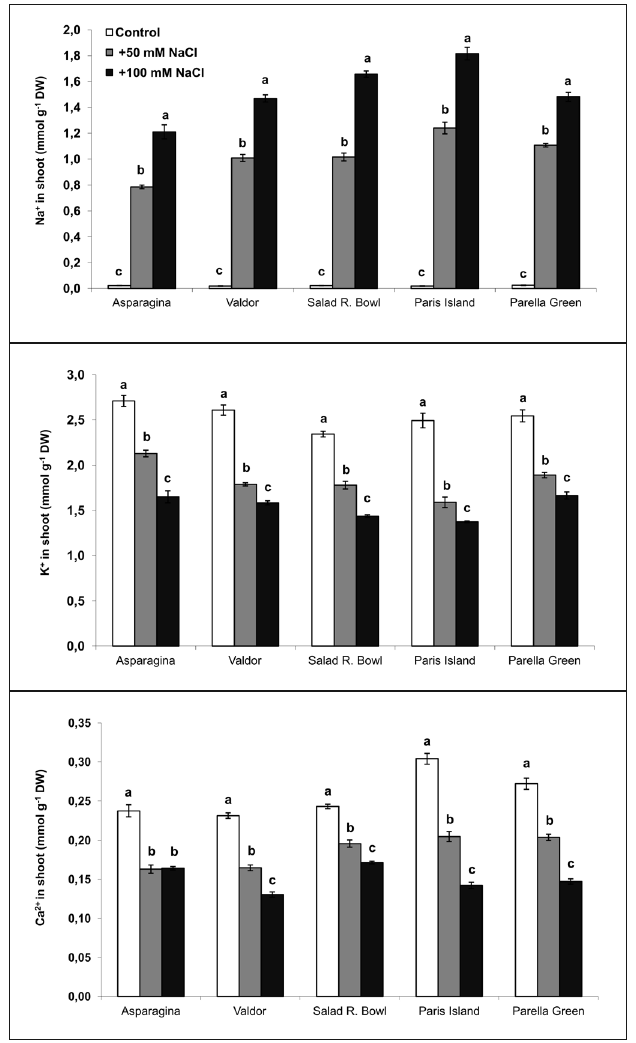
Fig. 5: Na + , Ca 2+ and K + content of shoot in five lettuce cultivars exposed to 50 mM and 100 mM NaCl. Bars represent means ± SE, n = 5. Dif - ferent letters indicate significant differences among treatments of the same cultivar, at P < 0.05, according to the Tukey test.